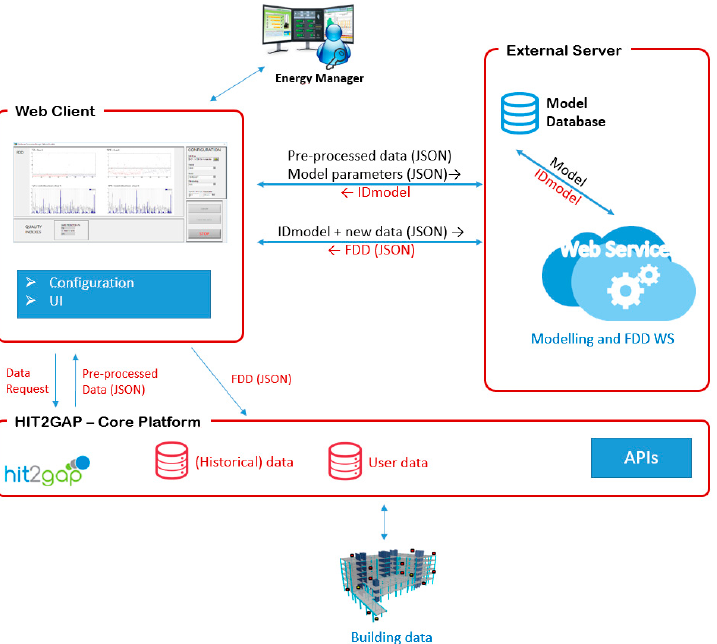
Figure 1. Application deployment diagram. On where, Fault detection and diagnosis (FDD), JavaScript Object Notation (JSON), User interface (UI), Web Service (WS), Application Programming Interfaces (APIs).